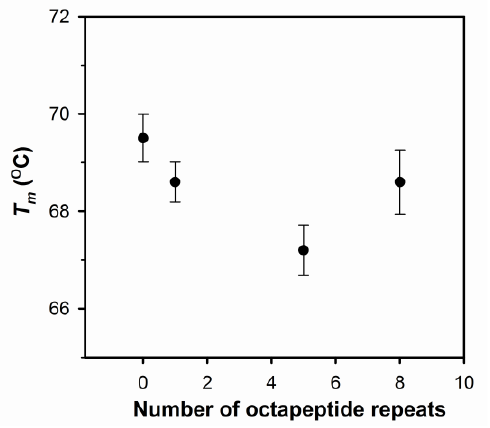
Figure 3. Thermal stability of four PrP variants compared by their T m values.